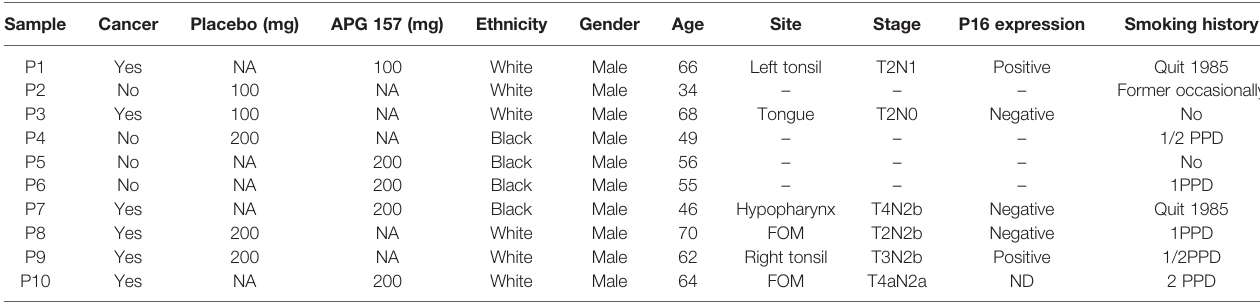
TABLE 1 | Characteristics of the study